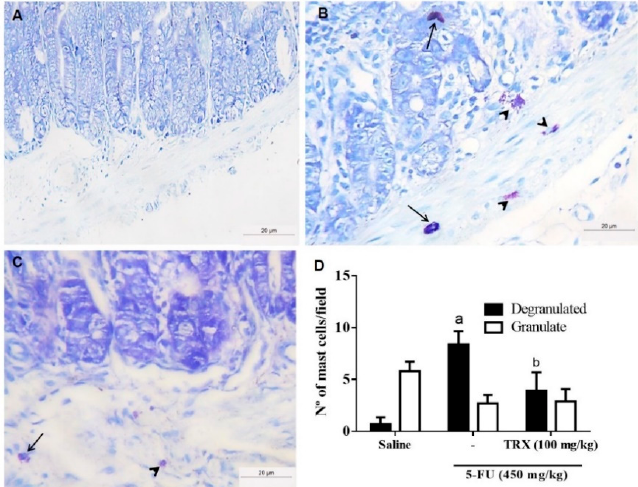
Figure 5. Mast cell counts in the duodenal segments based on toluidine blue staining. Panels ( A ), ( B ), and ( C ) correspond to Saline, 5-FU, and TRX-100 groups, respectively. ( D ): Statistical representation of experimental groups. Degranulated mast cells (arrow) and granulated mast cells (arrowhead). All the panels were obtained at ×400 magnification. Values are presented as mean ± SEM of the number of mast cells per field. For the statistical analysis, one-way ANOVA followed by Tukey’s test was used. a: p < 0.05 in 5-FU vs. Saline group; b: p < 0.05 in TRX-100 vs. 5-FU group.